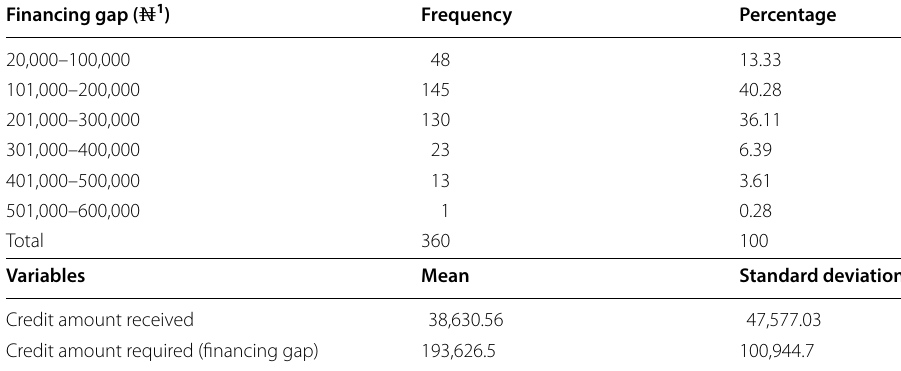
Table 4 Financing gap